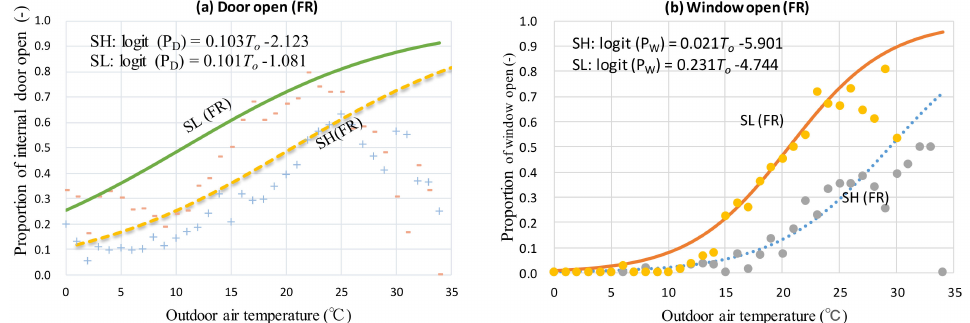
Figure 10. Relationship between door or window opening and outdoor air temperature of higher and lower groups: ( a ) Door open and ( b ) Window